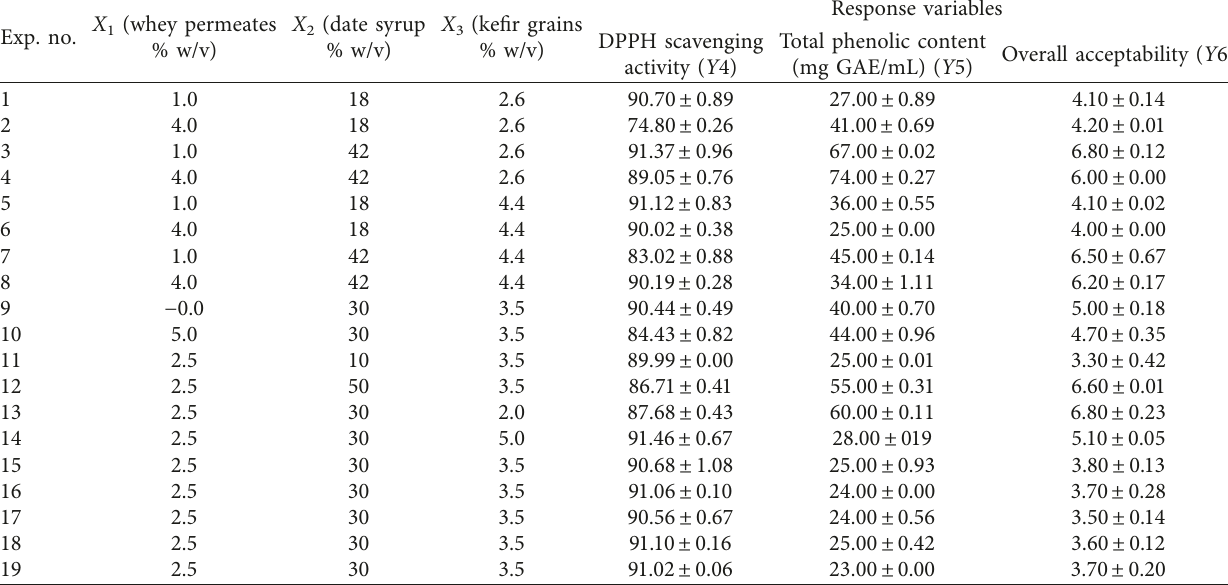
Table 3: Matrix of the central composite design (CCD) and observed responses for the response variables (DPPH scavenging activity, TPC, and overall acceptability).